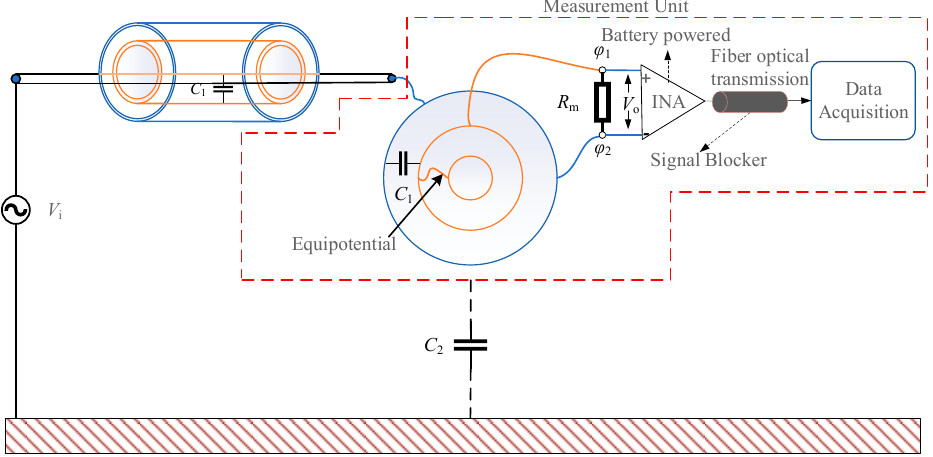
Figure 11. Schematic diagram of the grounding system with spatial capacitive coupling.